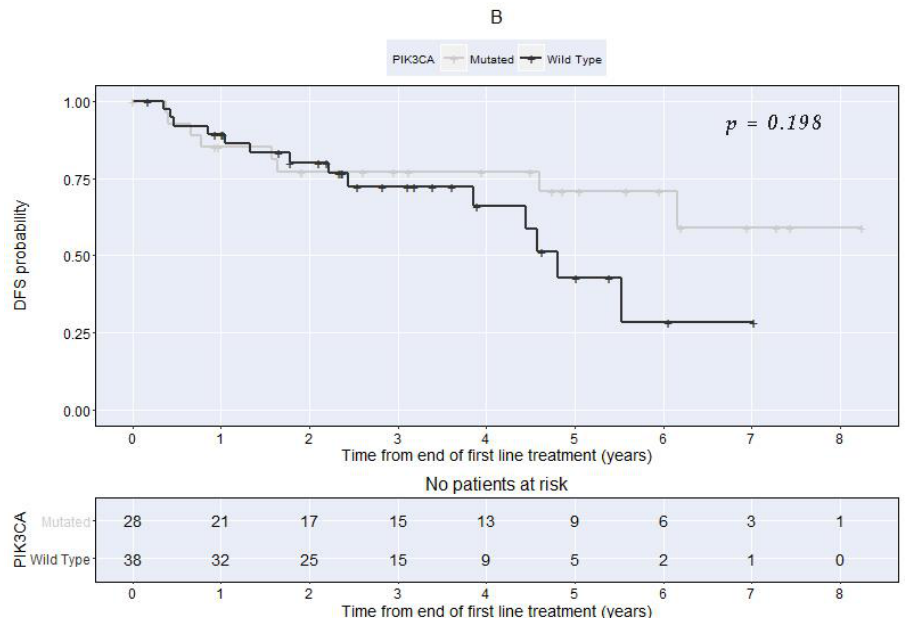
Figure 1. Kaplan – Meier curves comparing patients with PIK3CA-mutated vs. the wild-type at diagnosis ( A ). Overall survival (Log-rank test chi-square = 2.9 with 1 degree of freedom, p = 0.090). ( B ). Disease-free survival (Log-rank test chi-square = 1.7 with 1 degree of freedom, p = 0.198).